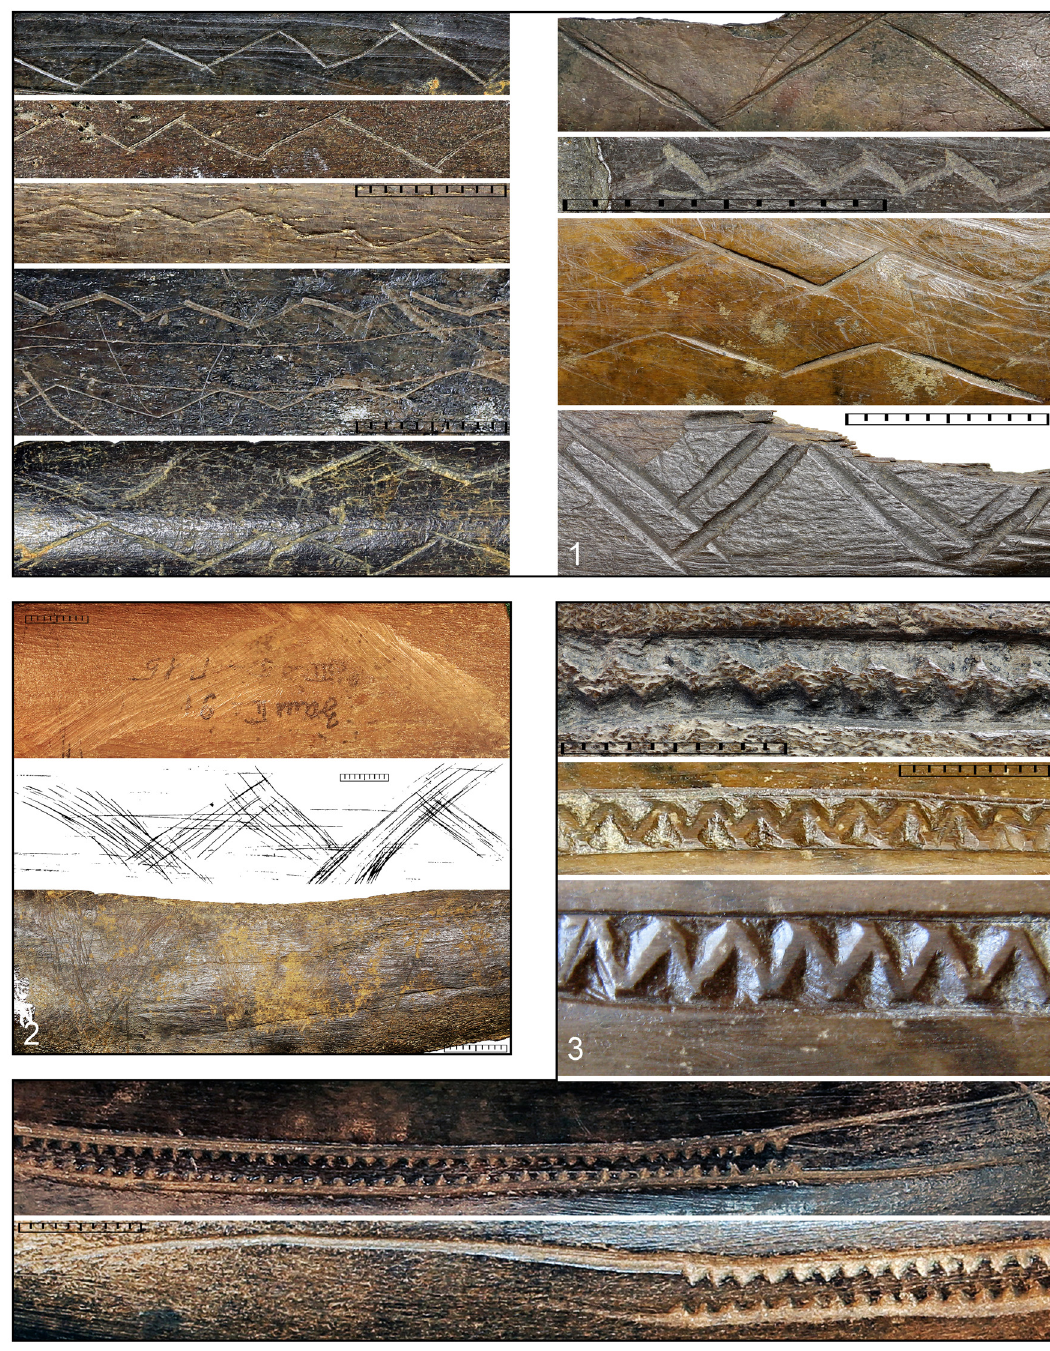
Figure 3: Zamostje 2. Application techniques: ( 1 ) engraving; ( 2 ) scraping; ( 3 )